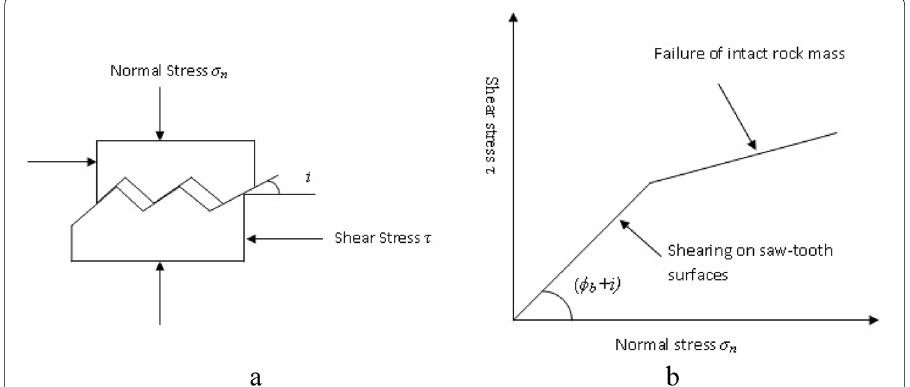
Fig. 2 Patton’s experiment on the shear strength of saw-tooth